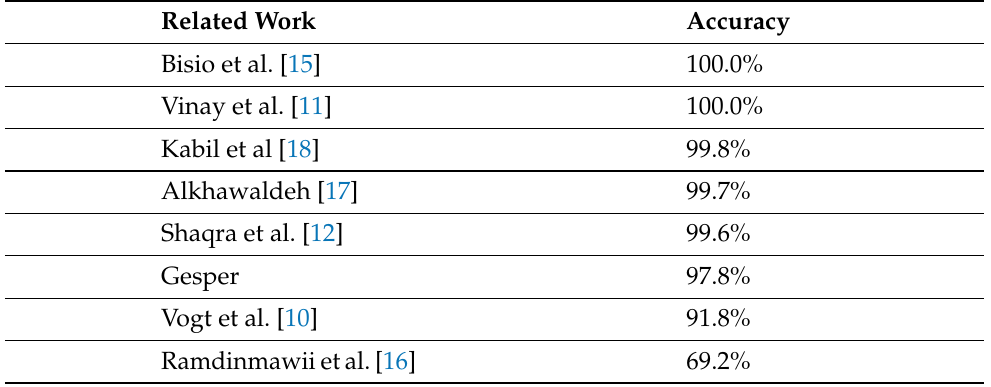
Table 2. Comparison between Gender Recognition accuracy of GESPER and literature related